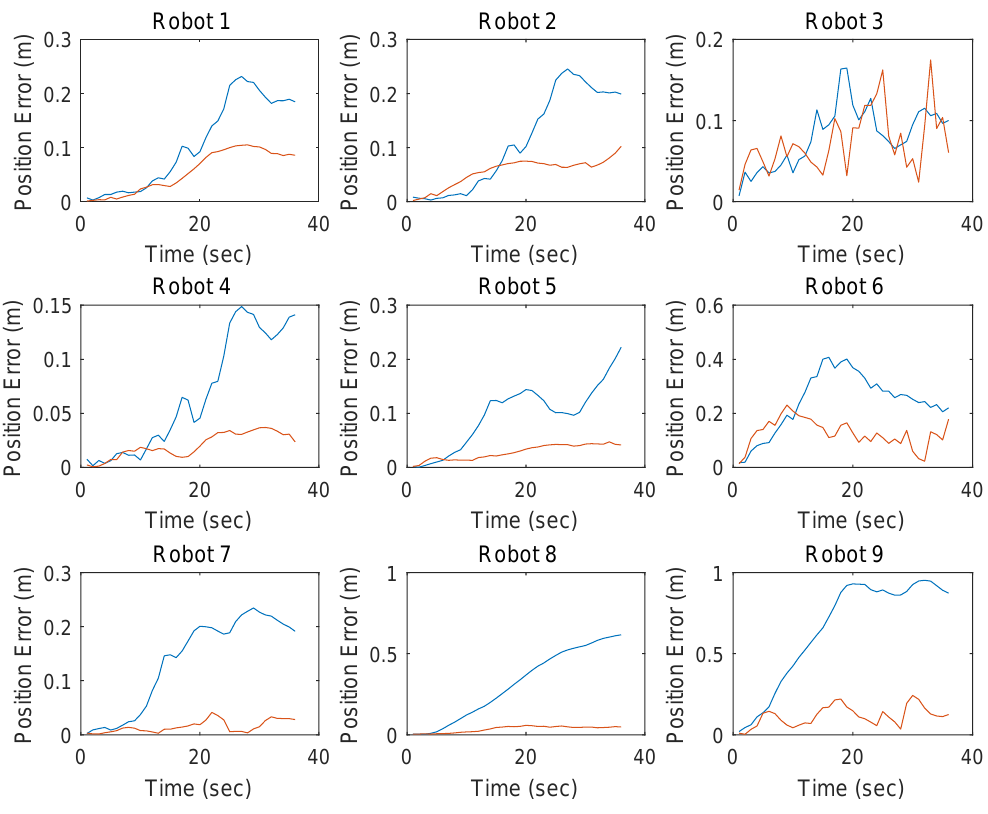
Figure 9. Position errors of 9 robots under additive white Gaussian